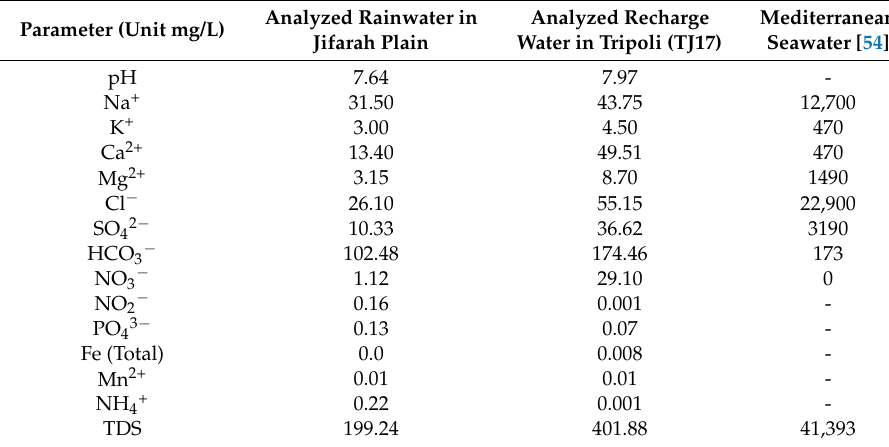
Table 2. Chemical composition of possible end